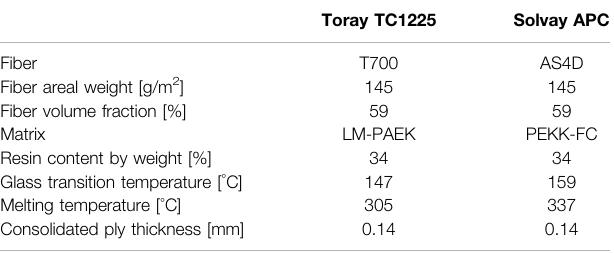
TABLE 1 | Overview of material characteristics, from Solvay Composite Materials HQ (2017) and Toray Advanced Composites